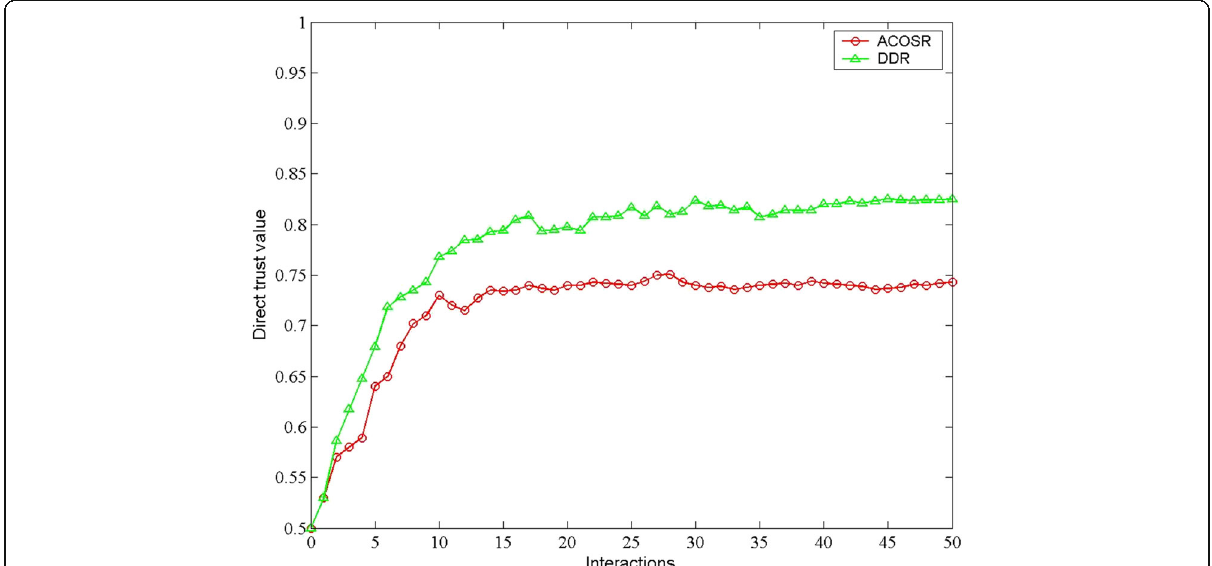
Fig. 1 Direct trust value in the case of no